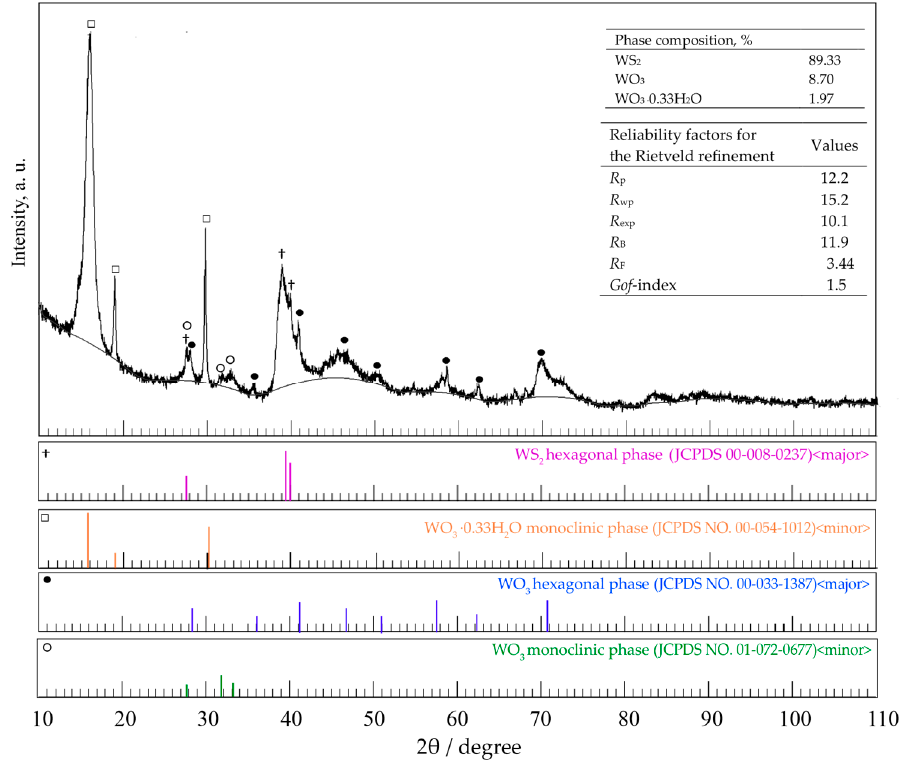
Figure 18. XRD pattern of commercial WS 2 powder.